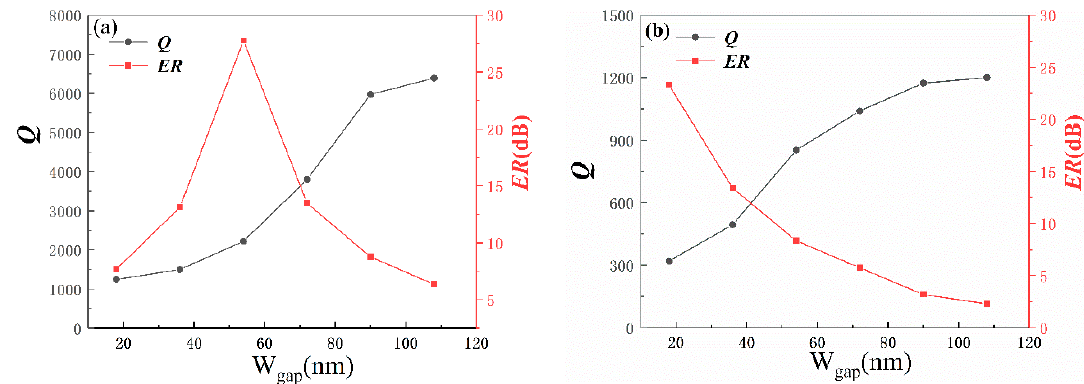
Figure 3. Q factor and ER of ( a ) WGM (1, 36) and ( b ) WGM (2, 28) as a function of W gap .